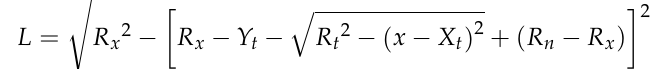
where R x is the roll radius at the given x-coordinate; R n is the roll nominal radius (i.e., the distance from the roll axis to the rolling centerline); R t is the radius of the tube flange profile; X t is the x-coordinate of the center point of the tube profile; Y t is the y-coordinate of the center point of the tube